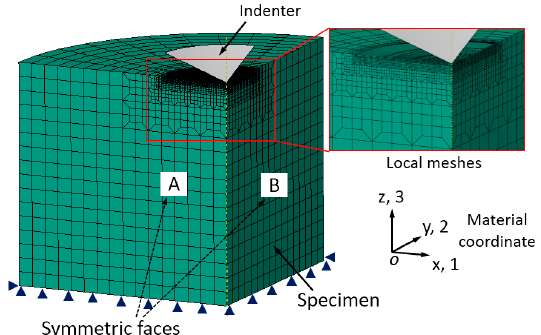
Figure 1. Finite element model, meshes, boundary conditions and material coordinate (right-hand) used in indentation simulation.